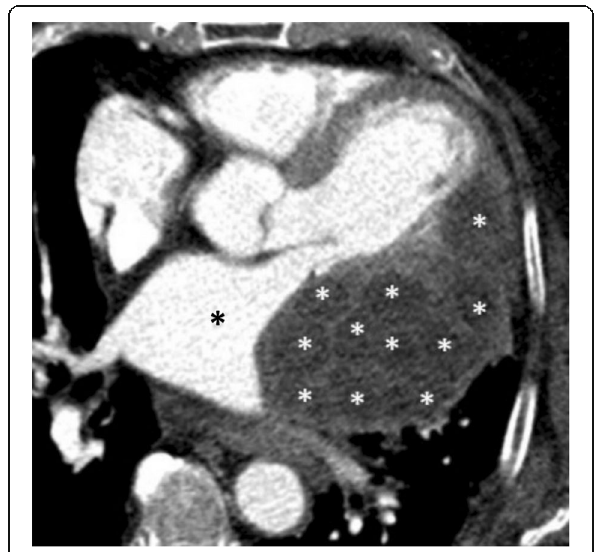
Fig. 20 A 86-year-old man with hydatid disease. Axial contrast- enhanced CT image reveals type 3 hydatid cyst containing multiple daughter cysts (white asterisks). Significantly compressed left atrium (black asterisk) due to hydatid cyst abutting the